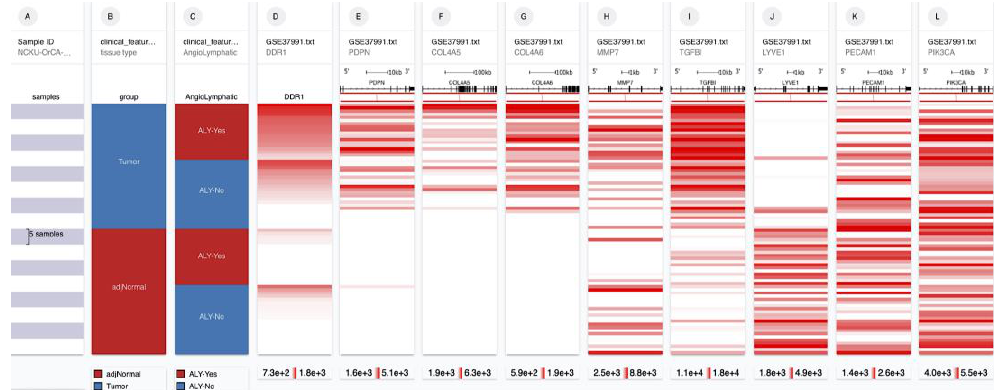
Figure A1. Integrated associations of angiolymphatic invasion phenotype (column C) of NCKU-OrCA-40TN (column B: 40T in blue; 40N in red), with gene expression of DDR1, PDPN, COL4A5, COL4A6, MMP7, and TGFBI by using UCSC Xena platform [59]. LYVE1 (lymphatic vessel marker), PECAM1 (CD31, vascular vessel marker), and PIK3CA are included as controls.